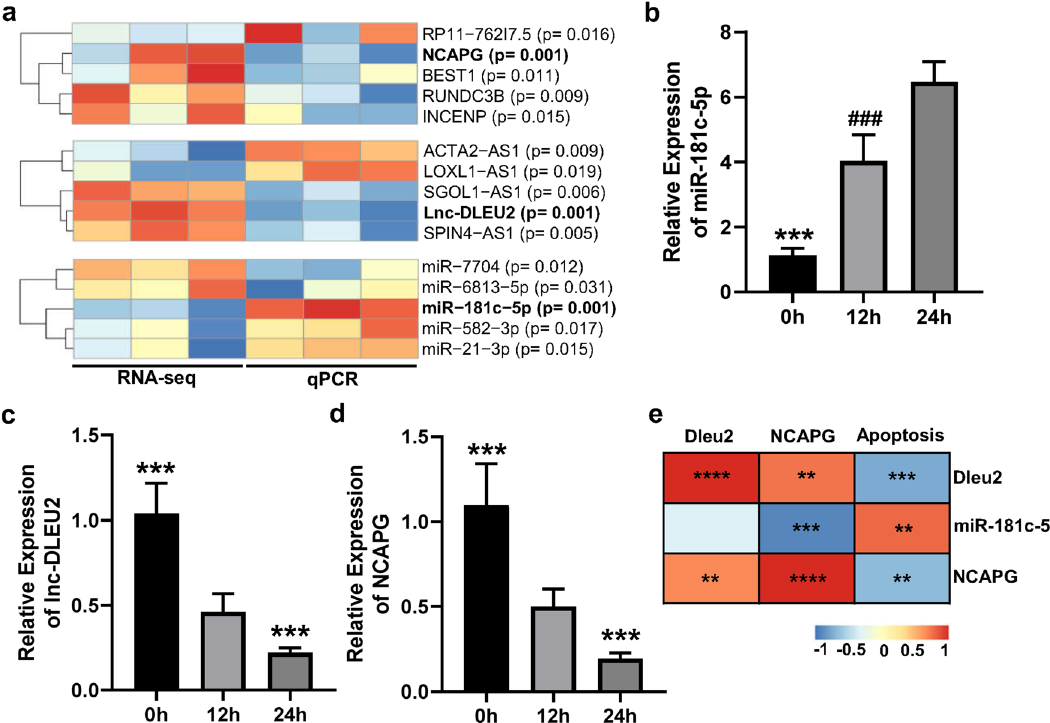
Figure 2. Transcripts most significantly modulated by hyperoxia in LMECs were closely associated with apoptosis. ( a ) Heatmap of the expression levels of the most significant top 5 mRNAs, lncRNAs and miRNAs regulated by hyperoxia in LMECs. ( b – d ) Changes in the expression of miR-181c-5p ( b ), lnc-DLEU2 ( c ) and NCAPG ( d ) in LMECs treated with hyperoxia for different times. Data are presented as mean ± SEM. One-way ANOVA analysis with Tukey’s post hoc test was used for statistical analysis in ( b – d ). ***: corrected p < 0.001 versus other groups; ###: corrected p < 0.001 versus 24 h groups. ( e ) Heatmap of Spearman’s correlation coefficients between apoptosis rate and the expression levels of miR-181c-5p, lnc-DLEU2 and NCAPG. **: p < 0.01; ***: p < 0.001; ****: p < 0.0001. Figure ( a , e ) were drawn by R Software (R-4.0.0 Version, https:// www.R- proje ct. org) 23